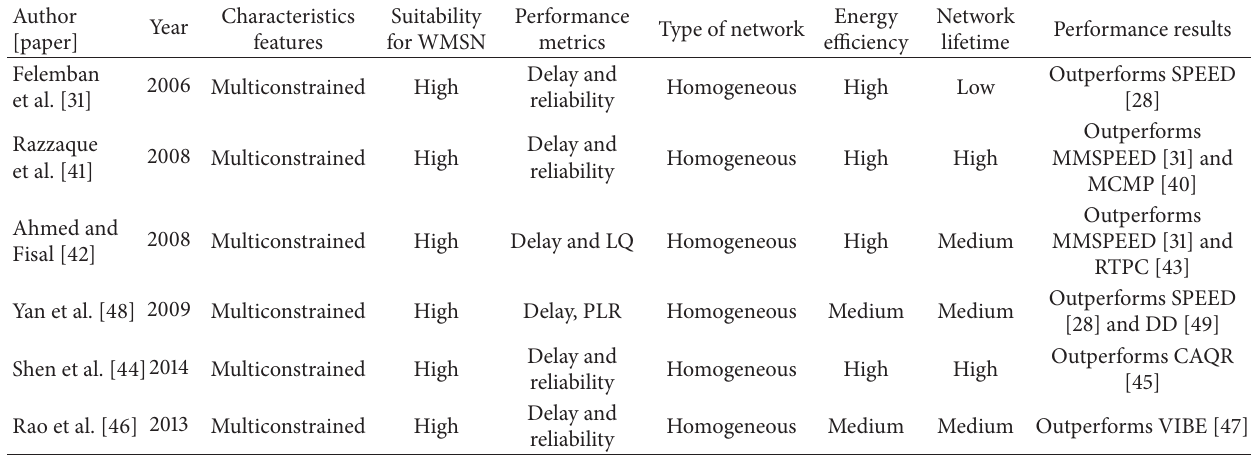
Table 3: Multiconstrained routing